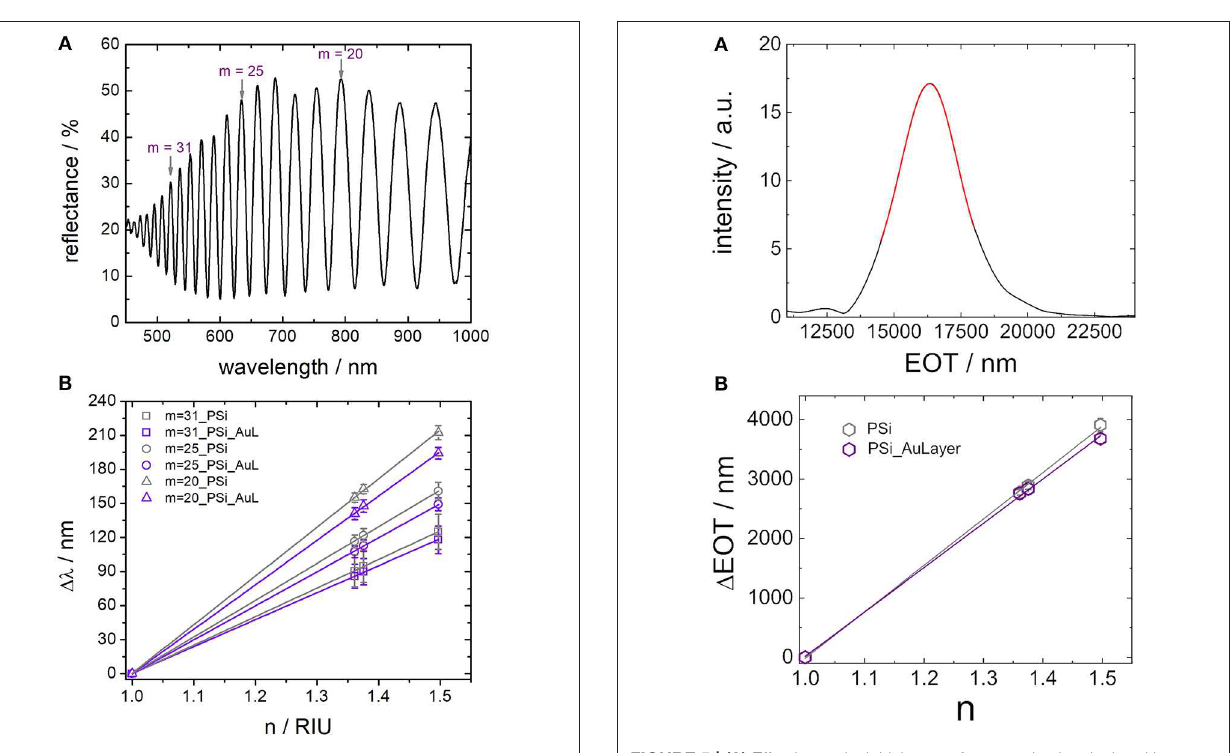
FIGURE 4 | (A) Reflectance spectra of a porous silicon sensor in air. The spectral order ( m ) refer to the interference maxima which were investigated in order to calculate sensitivities. (B) Determination of the sensitivity of sensors by plotting the position of single interference maxima on the wavelength scale vs. the refractive index of the surrounding medium.